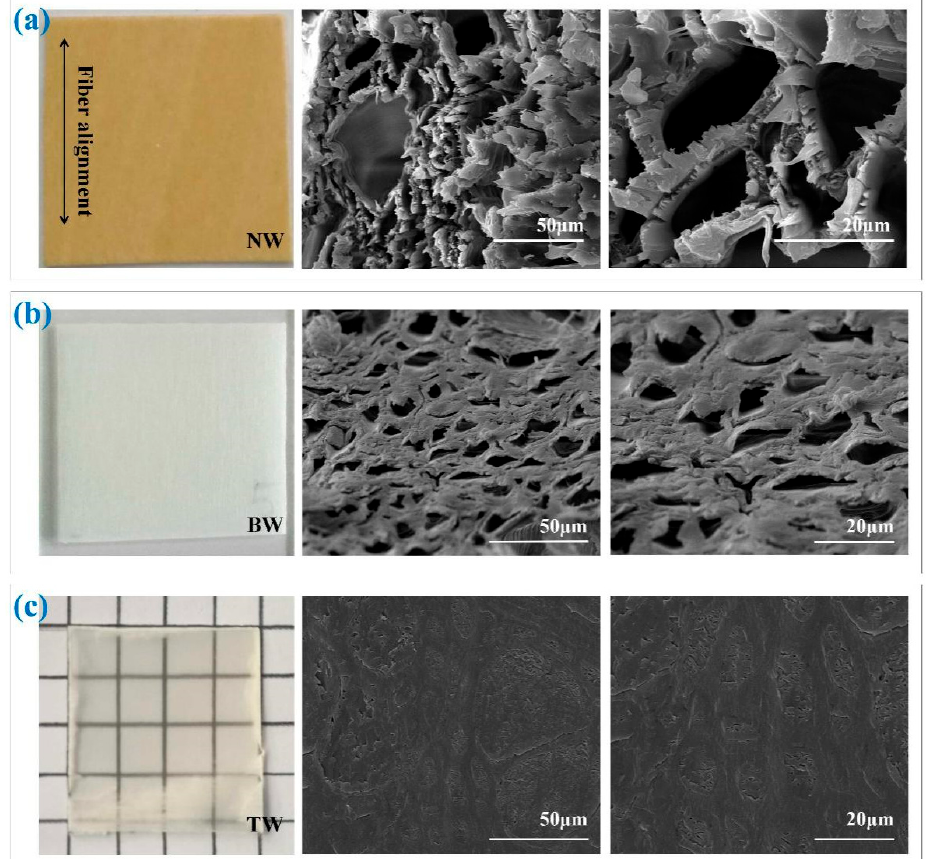
Figure 4. Photographs and SEM images of ( a ) natural wood (NW), ( b ) bleached wood (BW-150) and ( c ) transparent wood (TW-5) samples. 249